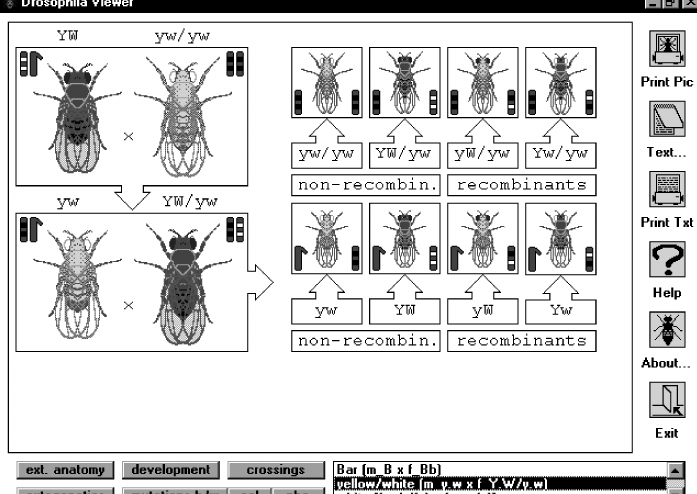
Figure 5 - Color photomicrograph showing three different stages of pupal development in Drosophila (original prepara- tion and photograph). The picture was selected by clicking the item in the list shown on the right after pressing the command button “development.”